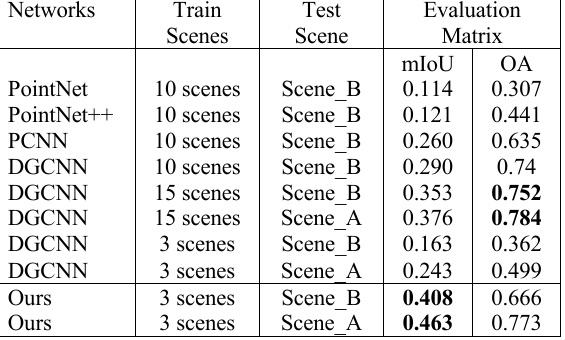
Figure 3 . Qualitative results for semantic segmentation. The top Table 1 . Our results vs prior works on Architectural Cultural row is the ground truth, and the second row is the prediction Heritage (ArCH) Data Set. OA and mIoU denote overall result of “Scene_A”. The bottom row is the ground truth and accuracy and mean Intersection-over-Union, respectively. Our output semantic segmentation result of “Scene_B”. Same scenes method performs the best on mIoU with only 3 scenes (about are displayed in the same camera viewpoint. 10% of 10 scenes).